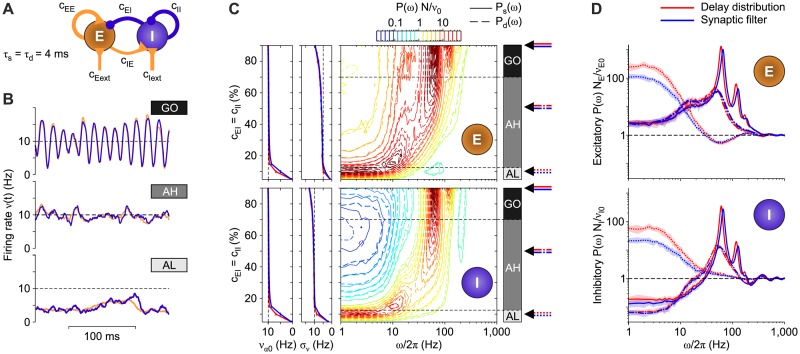
Comparison between multi-modular networks of inhibitory and excitatory LIF neurons with either synaptic filtering or transmission delay distribution.(A) Sketch of the multi-modular network. (B) Three examples of firing rate time evolution for each network stable state. Plum and orange curves represent inhibitory and excitatory neuronal populations, respectively, with synaptic filter. (C) Left plots: mean (να0, α = E, I) and standard deviation (σν) of the instantaneous firing rate across time (binning size of 0.1 ms, discarding the first second of the time series) for inhibitory (bottom panels) and excitatory (top panels) populations. Right plots: match between relative power spectral densities P(ω)N/να0 for excitatory (top panel) and inhibitory (bottom panel) populations with non-instantaneous synaptic transmission (solid lines) and distributions of transmission delays (dashed lines). Contour lines as in Fig 6D. Different states are obtained by increasing the connection probability with pre-synaptic inhibitory neurons, namely cαI ≡ cEI = cII (see text for details). The spectra P(ω) are averages across 10 simulations with different random synaptic matrix realizations. Dashed horizontal lines roughly mark the bifurcations. Rightmost arrows point out the values of cαI corresponding to the examples displayed in panels B and D. (D) Comparisons between relative spectra from networks with delay distribution (red lines) and synaptic filtering (blue lines) for the three network states AL (dotted lines), AH (dashed-dotted lines), and GO (solid lines), for excitatory (top panel) and inhibitory (bottom panel) populations.